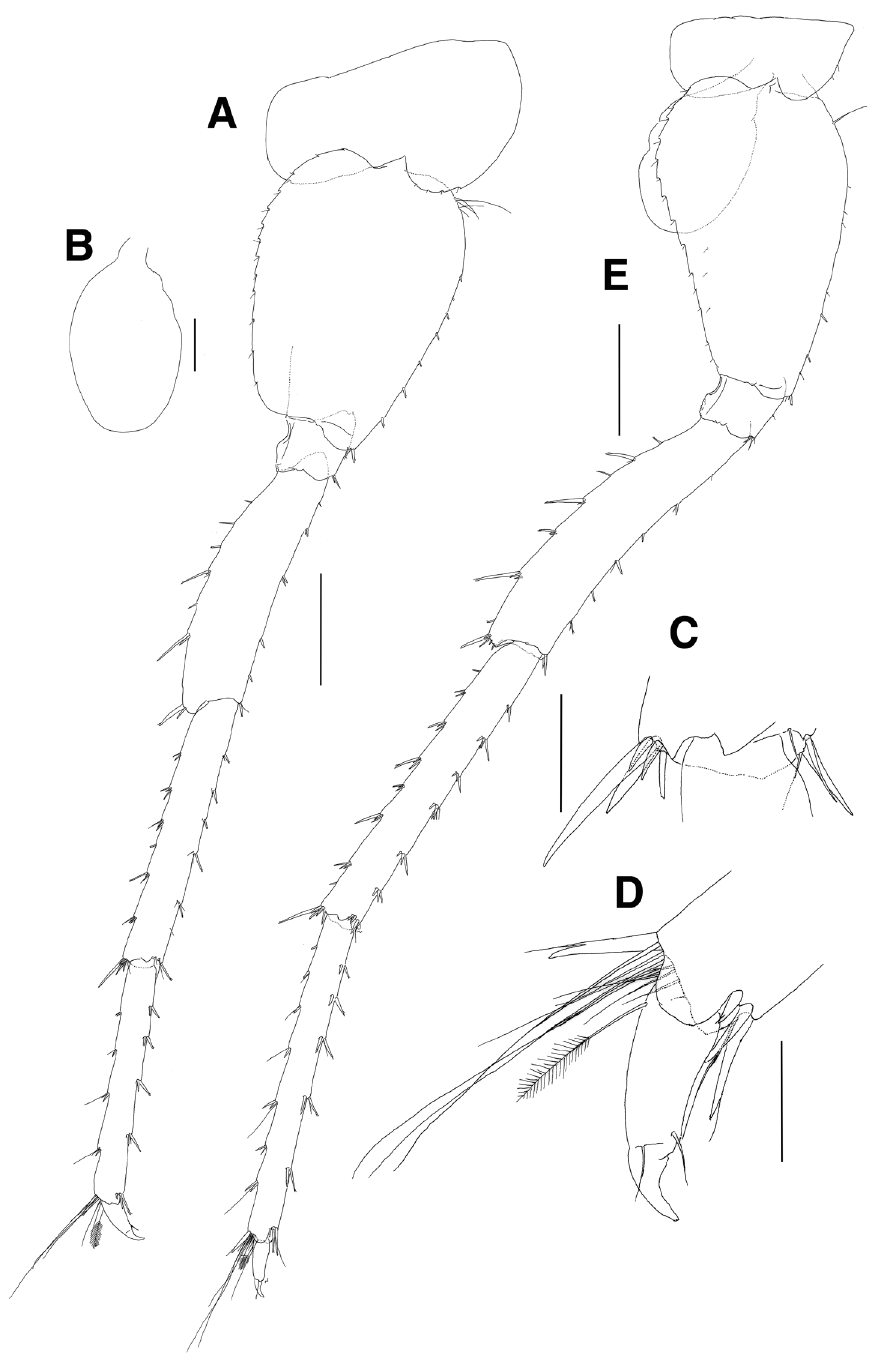
Figure 10. Paramoera dentipleurae sp. n., holotype. A Pereopod 5 B Coxal gill on pereopod 5 C Distal part of carpus on pereopod 5 D Dactylus on pereopod 5 E Pereopod 6. Scale bars 0.1 mm ( B ), 0.05 mm ( C, D ), 0.2 mm ( A, E